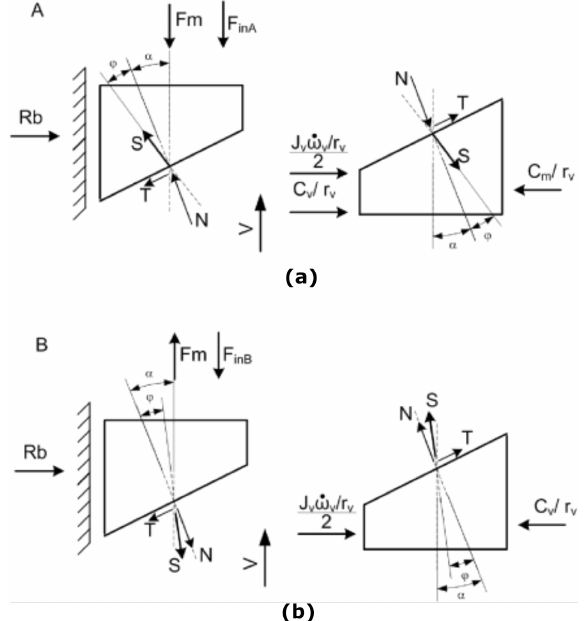
Figure 5. Subsystems A and B. ( a ) Screw section close to the motor. ( b ) Driven screw